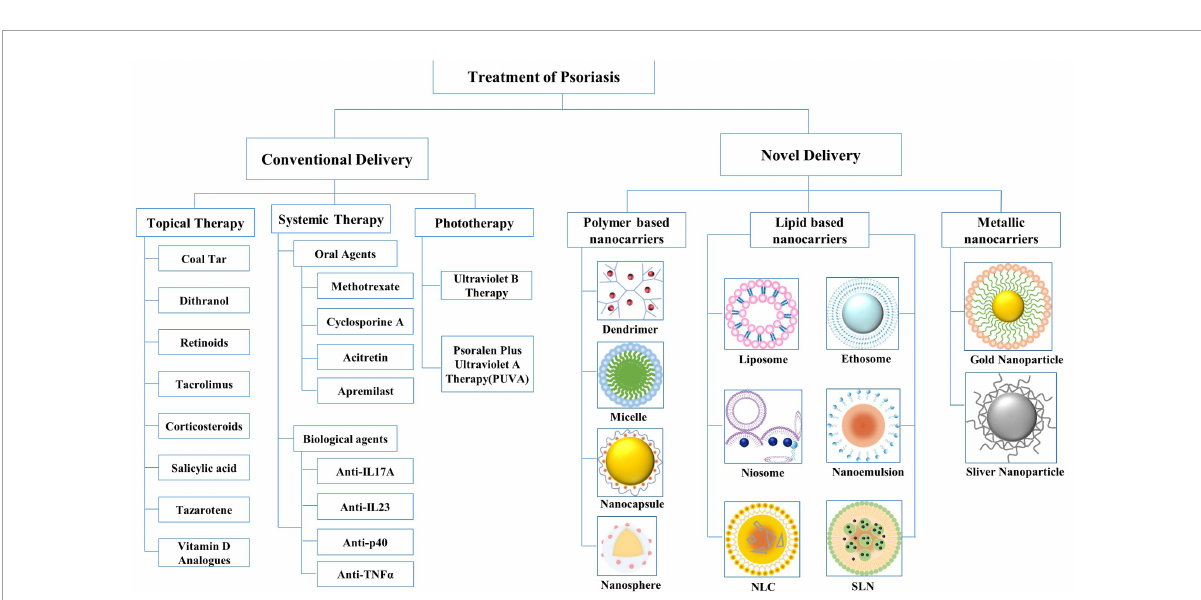
FIGURE2 Conventional drug delivery systems and novel drug delivery systems for the treatment of psoriasis. NLC, nanostructured lipid carriers; SLN, solid lipid